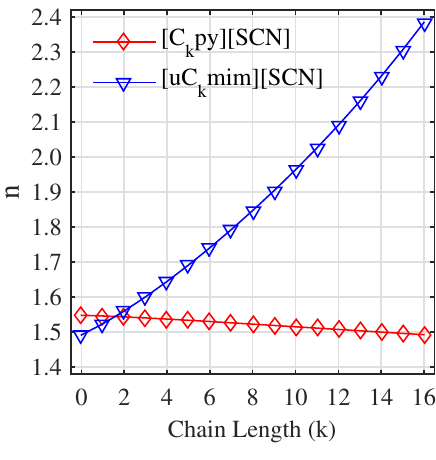
Figure 2. Refractive index extrapolation of [C k py][SCN] ( ⋄ ) and [uC k mim][SCN] ( ▽ ) families of ILs as function of the cation side chain